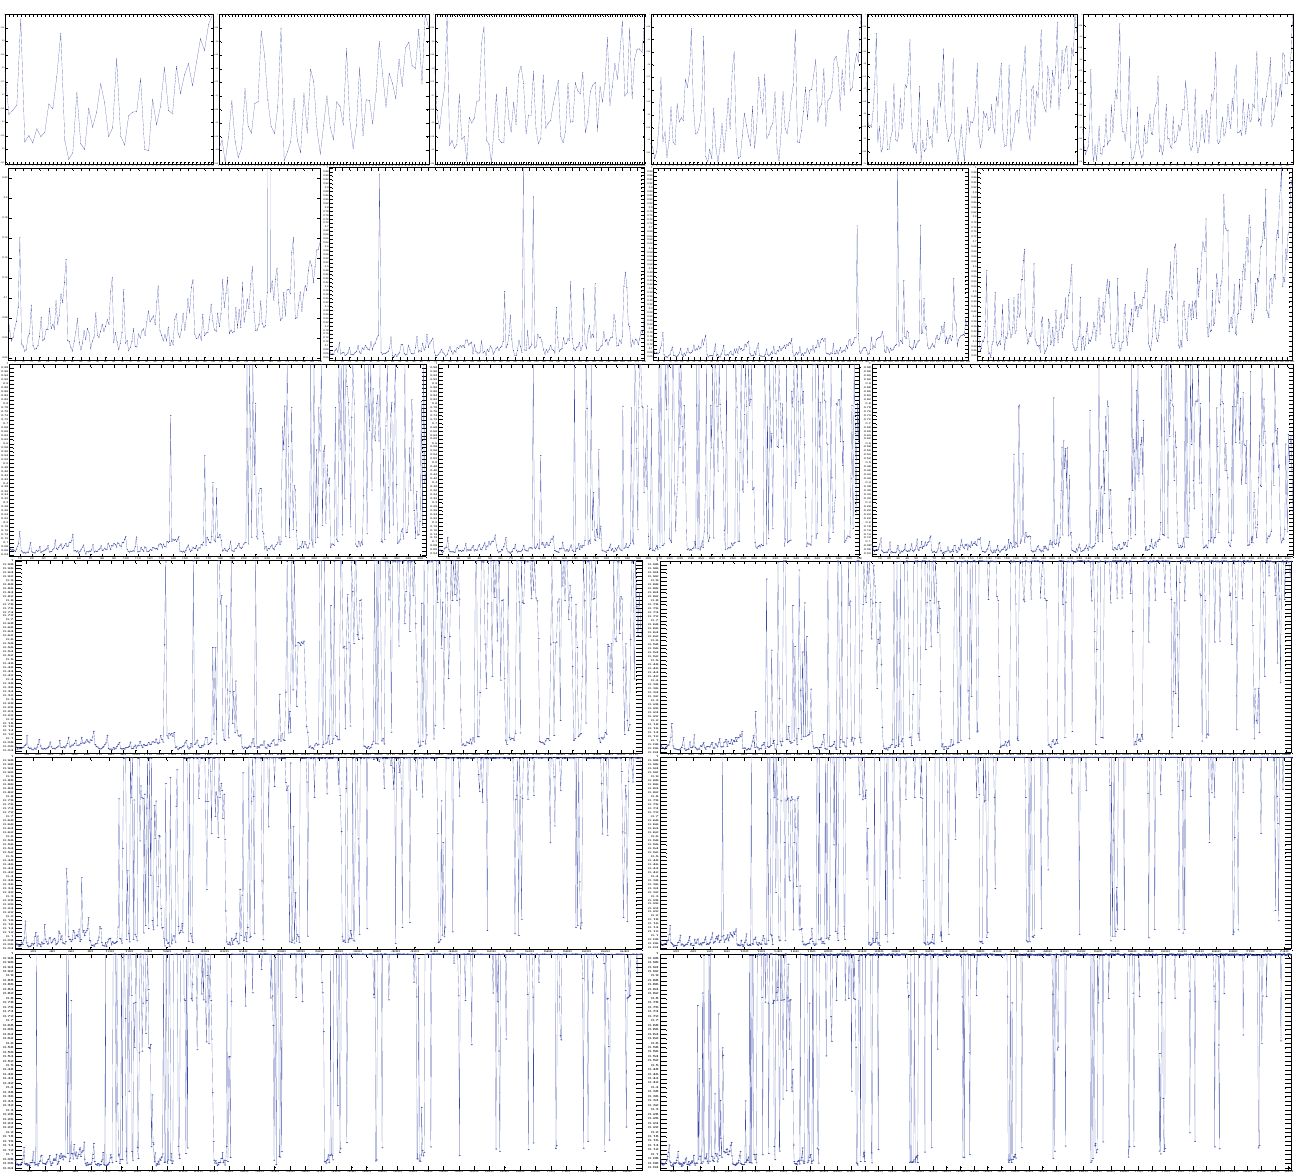
Fig. 3. The icon-like 19 polylines showing the normed averaged performance (21) against the ordered sequence of the filter spatial extents (to each image